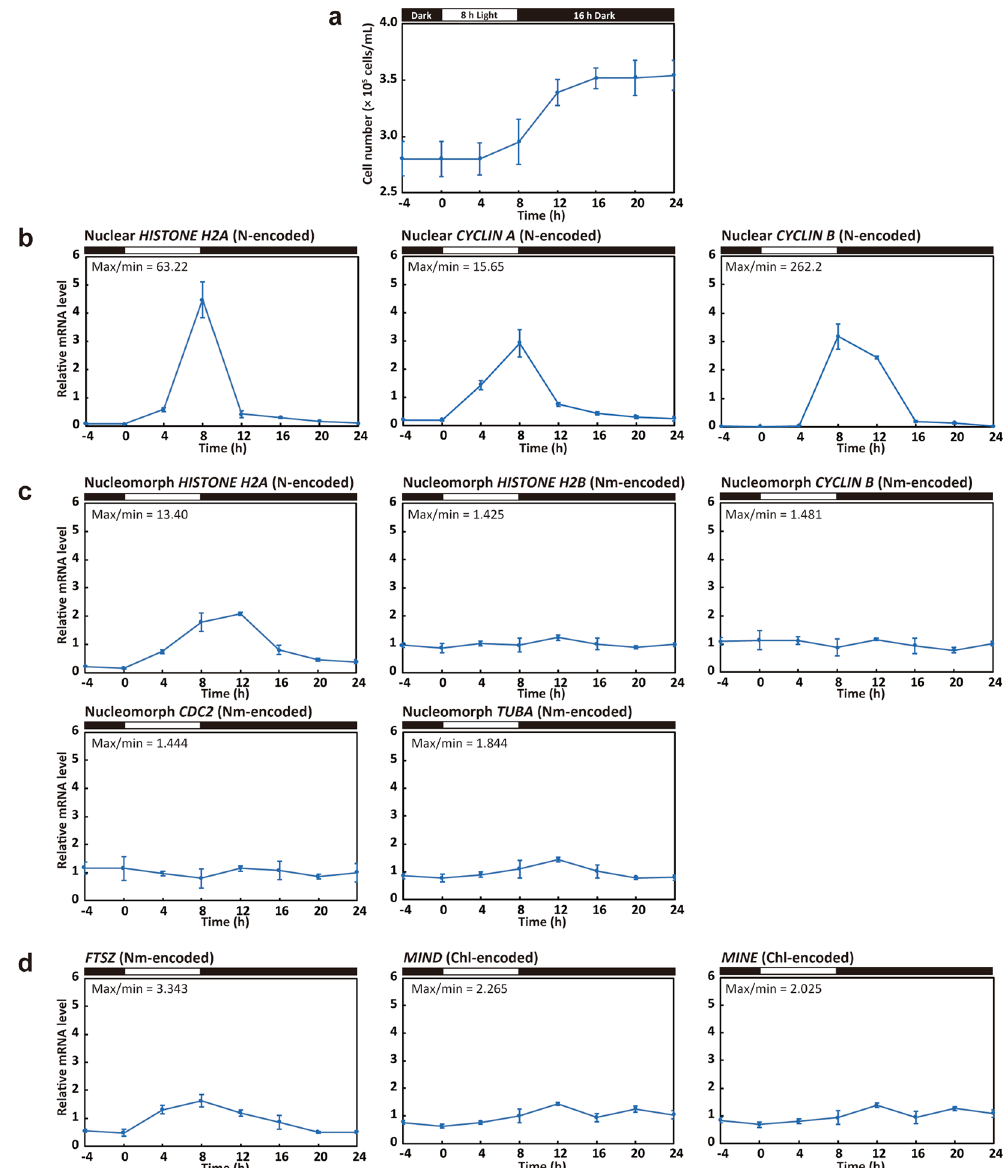
Figure 3. Change in the mRNA levels of the cell cycle marker genes and genes related to nucleomorph replication and chloroplast division in the synchronous G . theta culture. ( a ) Change in the cell density in the culture synchronized by the 8-h light/16-h dark cycle. The error bar represents standard deviation of six technical replicates. ( b – d ) Quantitative RT-PCR analyses showing the change in the mRNA levels of indicated genes. 18S ribosomal RNA was used as the internal control. The average value from hour 0 to 20 in the control culture was defined as 1.0 for each mRNA. The error bar represents standard deviation of three technical replicates. mRNA levels of the S-phase markers nuclear HISTONE H2A and CYCLIN A and M-phase marker CYCLIN B are shown in ( b ). mRNA levels of the nucleus-encoded nucleomorph HISTONE H2A and nucleomorph-encoded HISTONE H2B , C YCLIN B , CDC2 and TUBA are shown in ( c ). mRNA levels of the chloroplast division genes nucleomorph-encoded FTSZ and chloroplast-encoded MIND and MINE are shown in ( d ). “N-encoded”, “Nm-encoded” and “Chl-encoded” indicate nucleus-, nucleomorph- and chloroplast- encoded genes, respectively. “Max/min” indicates the ratio between maximum and minimum values from hour 0 to 24. A biological replicate of this experiment is shown in Supplementary Fig.